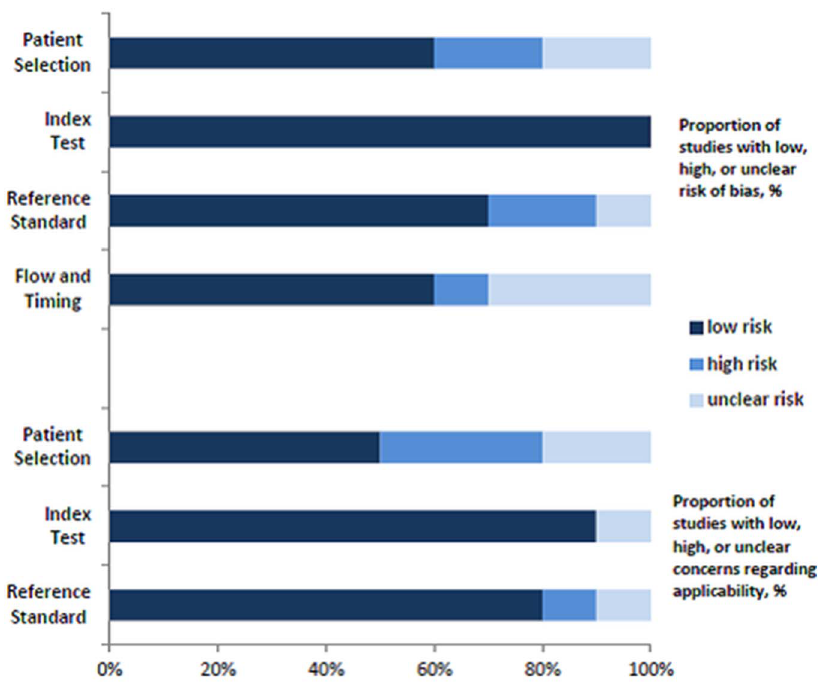
Figure 2. Risk of bias and applicability concerns of included studies examining role of NSE concentrations in prognosis in patients with traumatic brain injury.